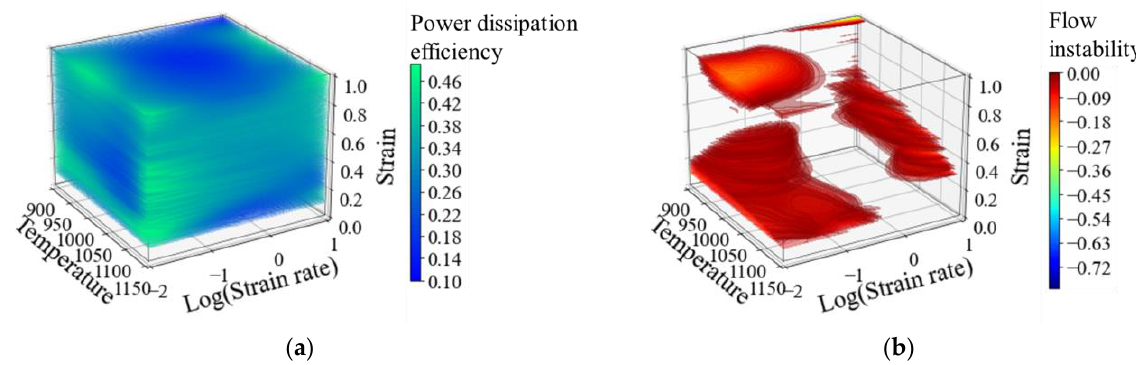
Figure 12. 3D processing map. ( a ) 3D power dissipation efficiency map, ( b ) 3D flow instability map.